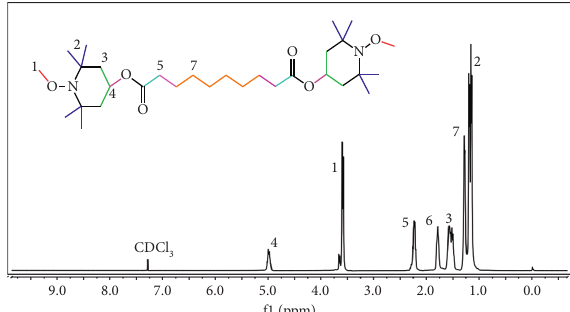
Figure 2: 1 H NMR of NORSM.